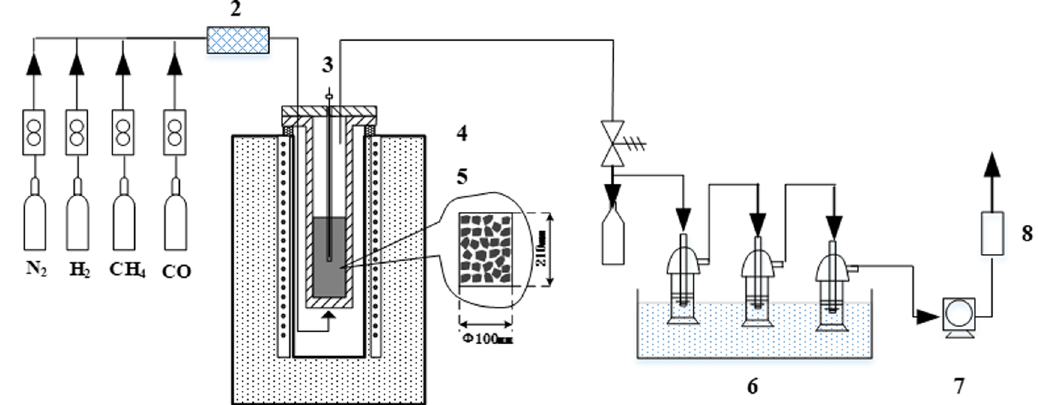
Figure 1: Pyrolysis device diagram. ( 1 ) Gas cylinder; ( 2 ) gas blending instrument; ( 3 ) sample temperature thermocouple; ( 4 ) temperature thermocouple inside furnace; ( 5 ) pyrolyzing furnace; ( 6 ) gas puri fi cation and tar collection; ( 7 ) pump; ( 8 ) gas